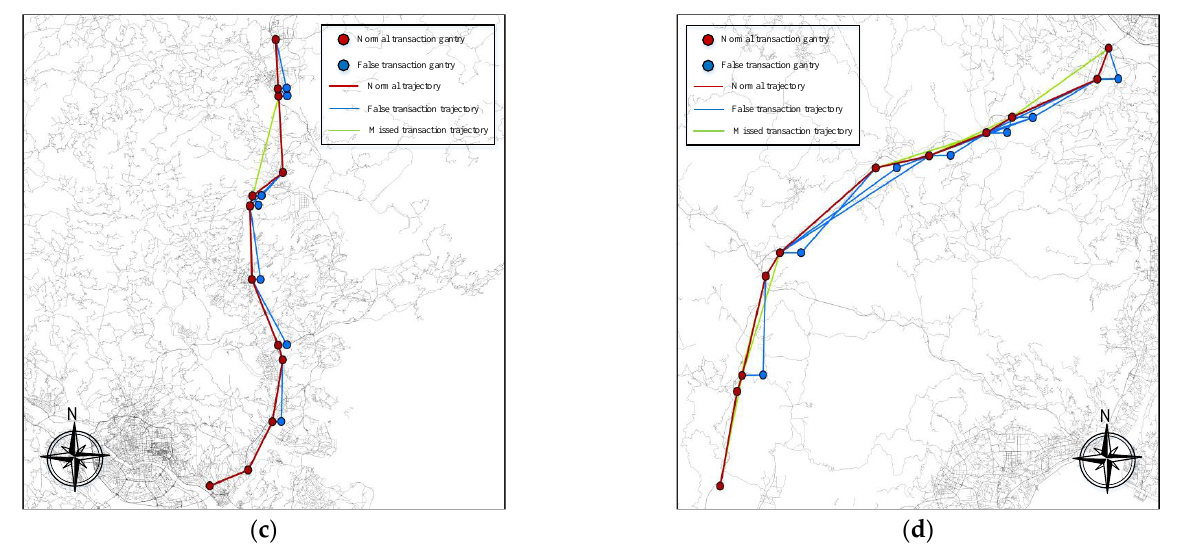
Figure 10. The abnormal transaction trajectory detection findings: ( a ) Nanpingbei-Minhouganzhe; ( b ) Yiban-Haicang. ( c ) Mawei-Ningdexi; ( d ) Xianyoubangtou-Fuzhounan. The figures show the driving trajectories of all vehicles passing through the selected four OD paths over three days. The red dot is the ETC gantry on the normal road, while the blue dot is the gantry on the adjacent road. The red trajectory line is the trajectory of the vehicle passing through the correct gantry (overlapping with the 𝑂𝐷𝐿𝑗 ), while the blue and green trajectories are the trajectories of the vehicles with false transactions or missed transactions. The abnormal transaction data account for the total number of trip transactions as shown in Figure 11.